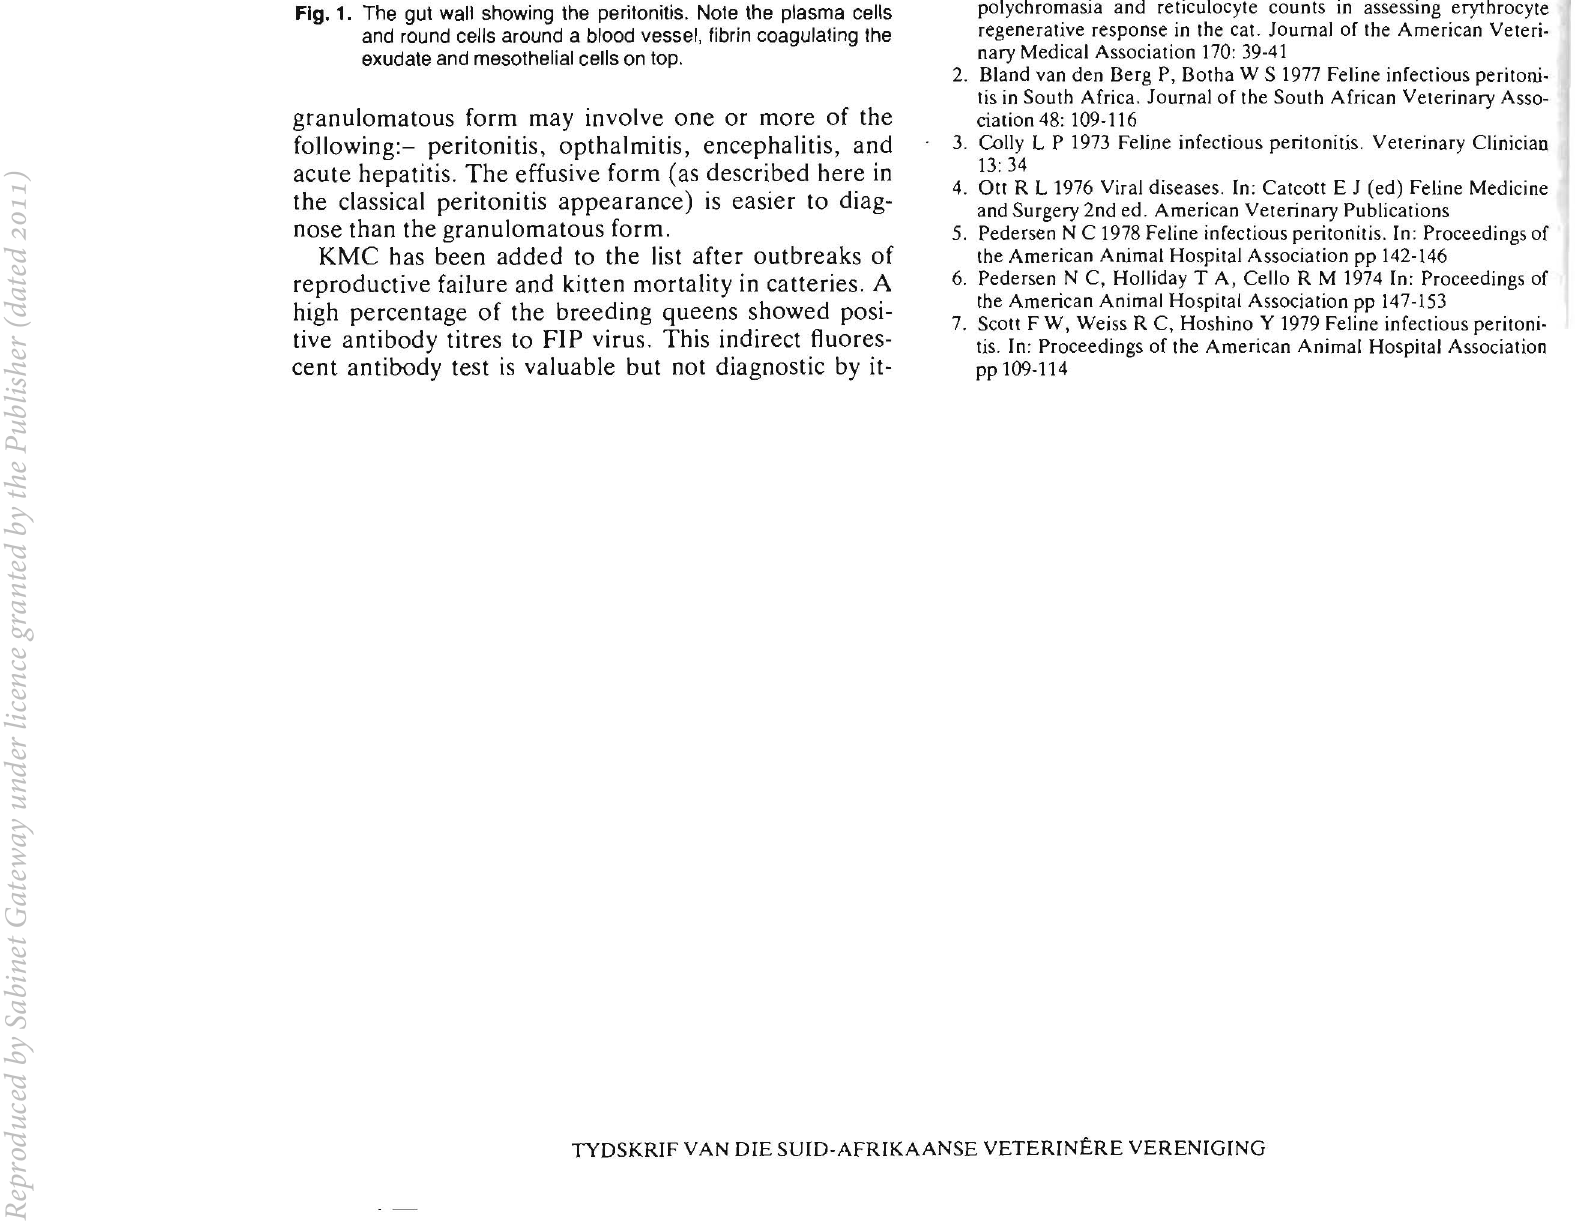
Fig. 1. The gut wall showing the peritonitis. Note the plasma cells and round cells around a blood vessel, fibrin coagulating the exudate and mesothelial cells on